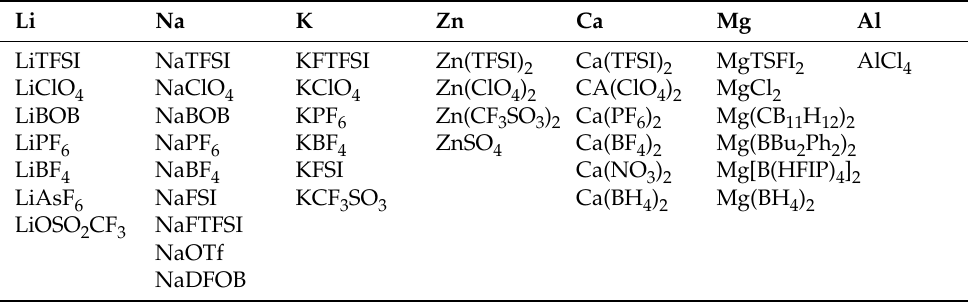
Table 16. Salts for electrolytes.